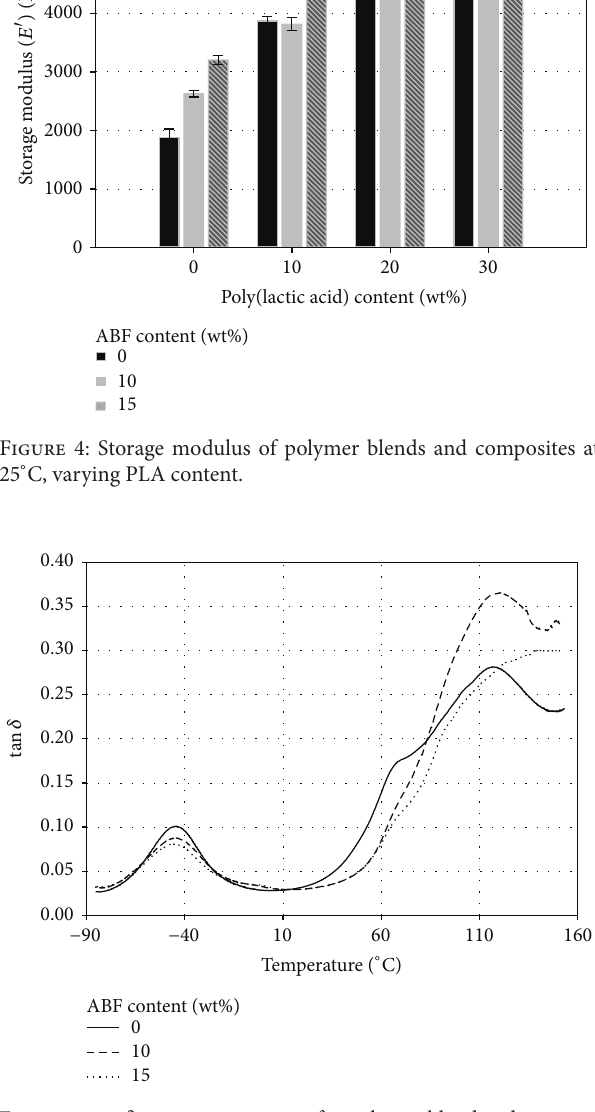
Figure 5: tan 𝛿 versus temperature for polymer blend and compos- ites containing 20 wt% PLA.